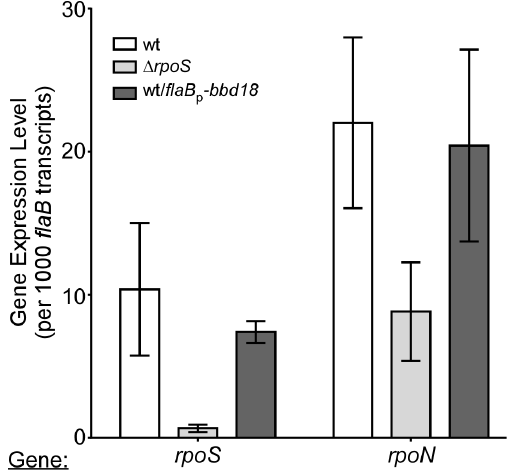
Figure 3. Analysis of the transcript level of alternative sigma factors rpoN and rpoS . qRT-PCR data displaying the transcript levels of rpoS and rpoN in strains B31-S9 (wt), B31-S9 D rpoS ( D rpoS ) and B31- S9/pBSV2*- flaB p- bbd18 (wt/ flaB p- bbd18 ) grown under rpoS -inducing conditions. Levels of rpoS and rpoN transcripts are displayed in relative units per 1000 copies of flaB transcript. Transcript levels were analyzed using Student’s unpaired t-test and no statistically significant difference was detected (p . .05).